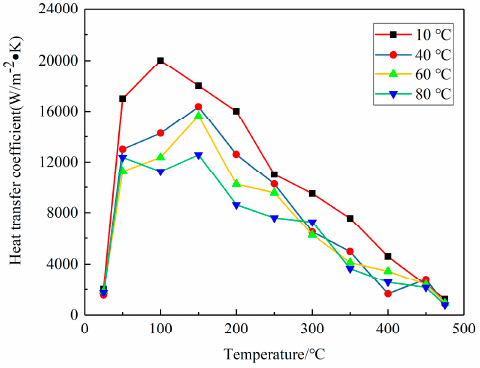
Figure 6. Modified heat transfer coefficients (HTCs) for water with different temperature.